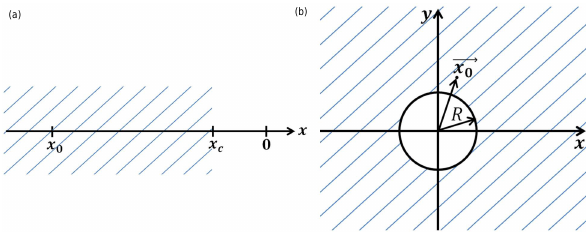
Figure 2. Schematic diagram in 1-D (a) and 2-D (b) . Hatched areas show semi-infinite domains outside of the